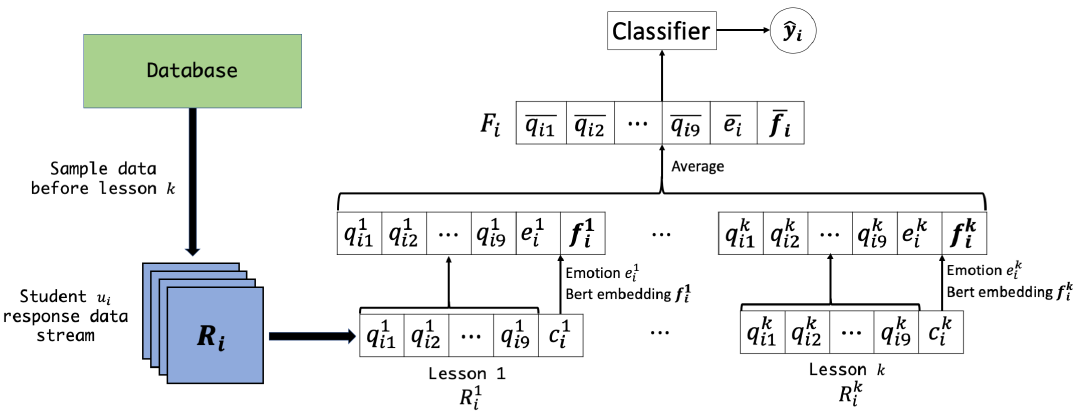
Figure 4. Data pre-processing